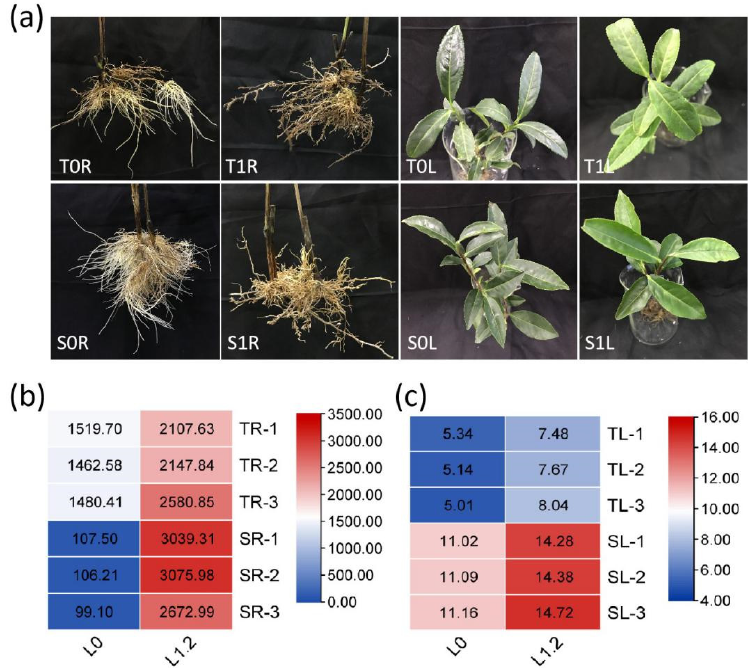
Figure 1. Effect of La on tea growth and La accumulation. ( a ) Growth of Shuixian and Tieguanyin under La treatment; ( b ) La accumulation in the roots of Shuixian and Tieguanyin, Units: mg/kg; ( c ) La accumulation in the leaf of Shuixian and Tieguanyin, Units: mg/kg. T0L, Tieguanyin leaf under the control treatment; T1L, Tieguanyin leaf treated with 1.2 mmol/L La; S0L, Shuixian leaf under the control treatment; S1L, Shuixian leaf treated with 1.2 mmol/L La; T0R, Tieguanyin roots under the control treatment; T1R, Tieguanyin roots treated with 1.2 mmol/L La; S0R, Shuixian roots under the control treatment; S1R, Shuixian roots treated with 1.2 mmol/L La.